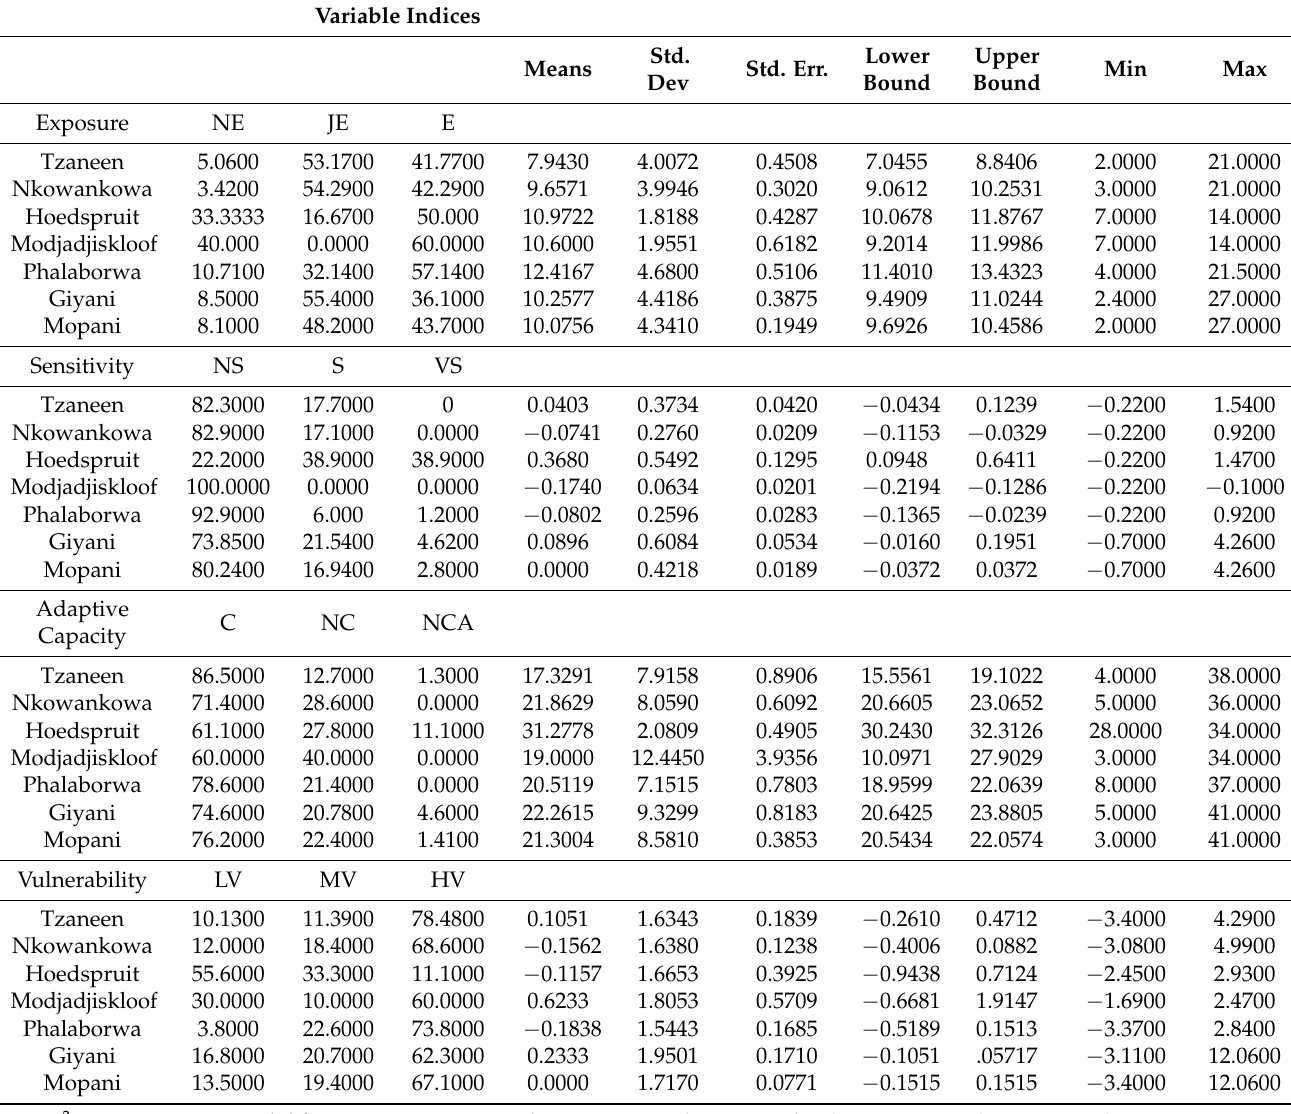
Table 3. Summary of the Distribution Households’ Vulnerability Index across